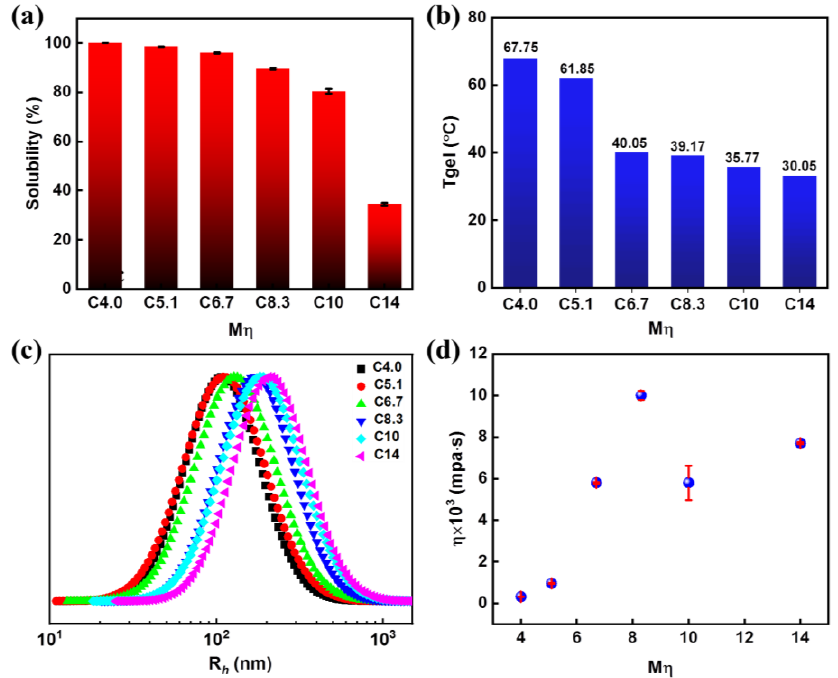
Figure 7. The solubility ( a ), gel temperature ( b ), DLS curves ( c ), and viscosity ( d ) of bamboo cellu- lose with different M η in LiOH/urea aqueous